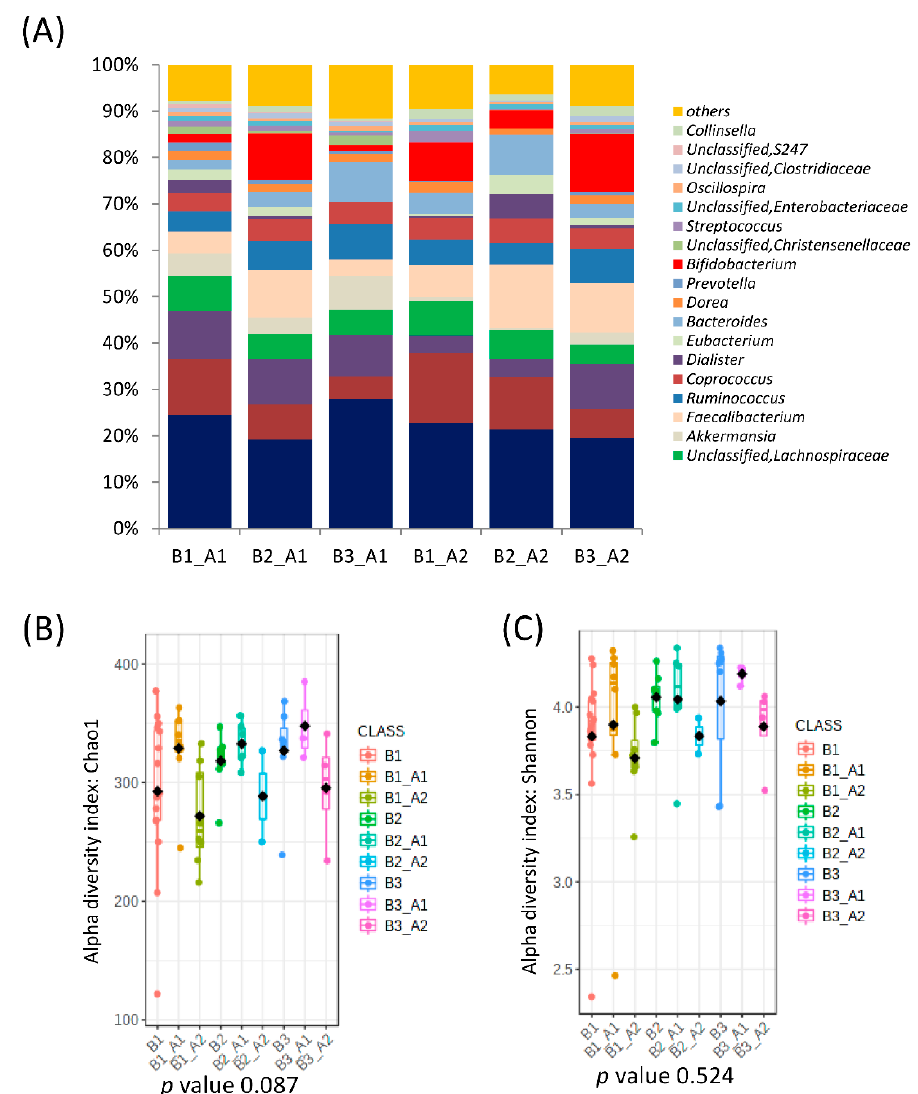
Figure 4. Microbial clusters and representative microbial taxa at the genus level according to migration groups between baseline clusters and after the intervention. ( A ) Relative abundances at the genus level according to migration groups between baseline clusters and after the intervention. ( B , C ) Microbial α diversity indexes according to microbial cluster change after intervention richness (Chao1 index) ( B ) and diversity (Shannon index) ( C ).